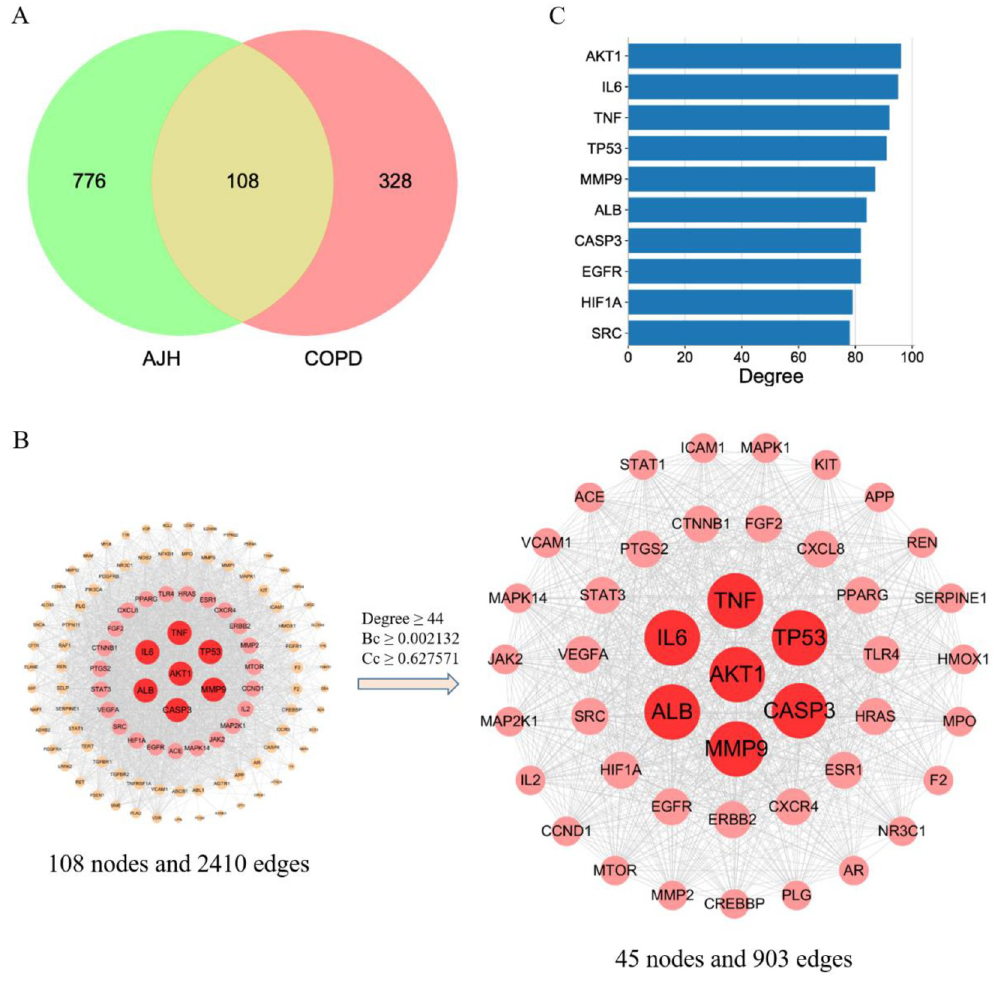
Fig 3. Network of common targets. (A) Intersection of Venn diagram. (B) PPI network of common targets. (C) Targets in the top ten